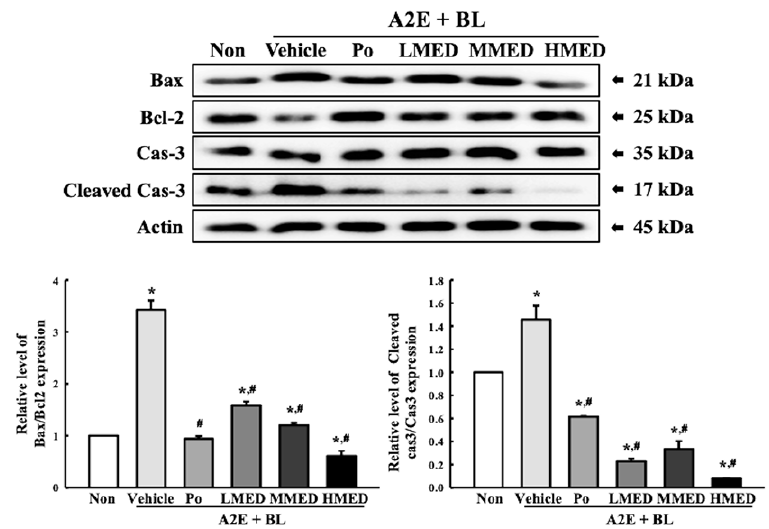
Figure 6. Expression of apoptotic proteins in MED + A2E + BL treated ARPE19 cells. After preparing total cell lysate from MED + A2E + BL treated ARPE19 cells, the expression level of Bax, Bcl-2, Cas-3 and Cleaved Cas-3 protein was measured by Western blotting analysis. The total proteins homogenates were prepared from two to three samples per group, and Western blot analyses for each sample was analyzed in duplicate. All values in results are represented as the means ± standard deviation (SD). * indicated statically significance compared to the Non treated group, while # indicated statically significance compared to the Vehicle + A2E + BL treated group. Abbreviations: Bax, Bcl-2-associated X protein; Bcl-2, B-cell lymphoma 2; Cas-3, Caspase-3; MED, methanol extracts of Dipterocarpus tuberculatus Roxb.; A2E: N-retinylidene-N-retinylethanolamine; BL, Blue light.